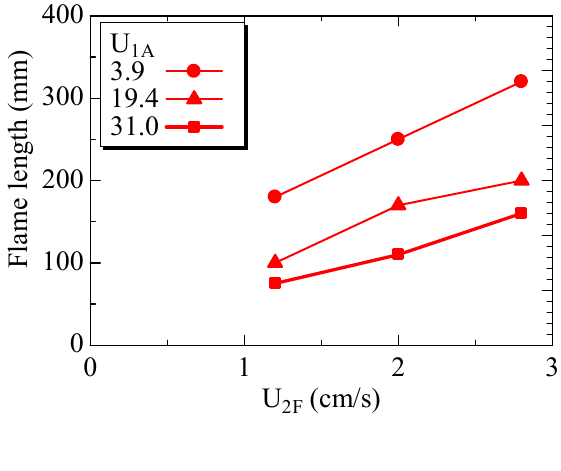
Figure 4. Flame length in triple port burner obtained by